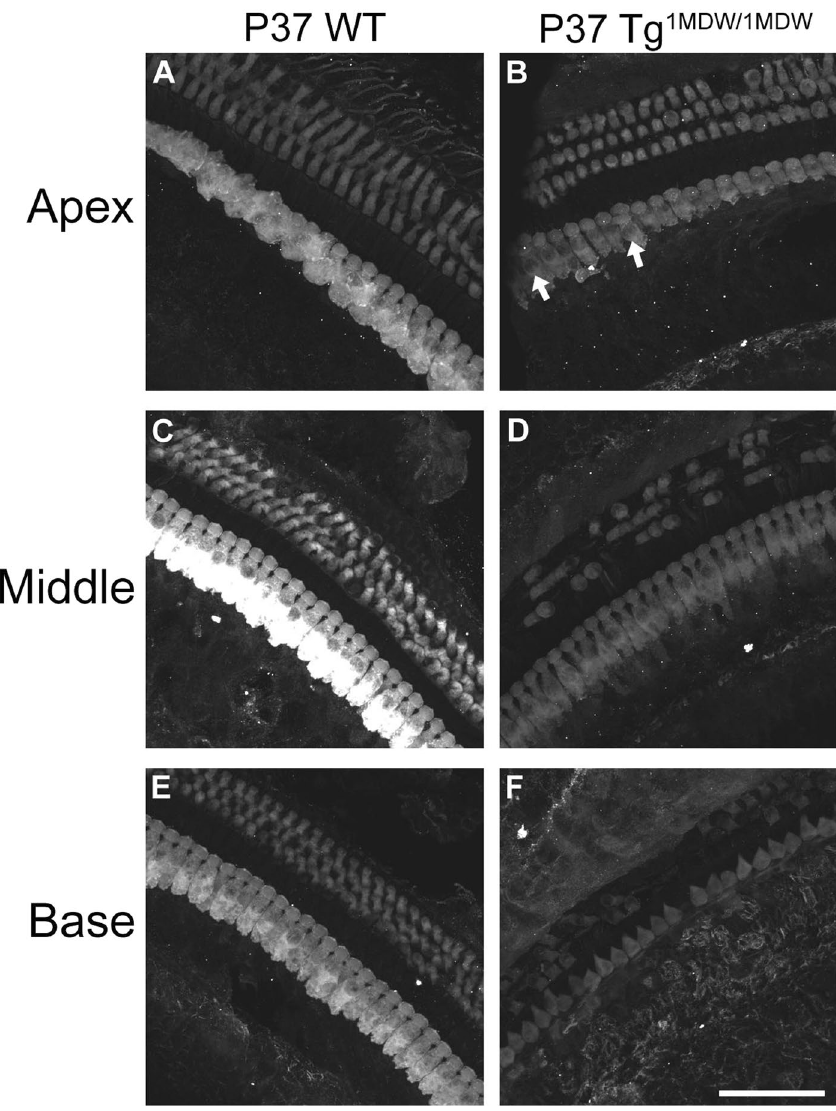
Figure 8. Gradients of HC loss and HC dismorphology in Tg 1MDW/1MDW at P37. Immunofluorescence of whole mount cochleae labeled with primary antibodies to MYO7a in P37 WT and Tg 1MDW/1MDW mice. The images are brightest point projections from Z series stacks parallel to the reticular lamina. Fields were imaged from comparable locations along the cochlear duct ( A , B Apex, C , D Middle, E , F Base). Note the base to apex decrease in OHC loss with the concomitant increase in shortened and rounded OHCs. The presence of extra medially located IHCs in the Tg 1MDW/1MDW apex are also noted (B, white arrows). Scale bar; 50 μ